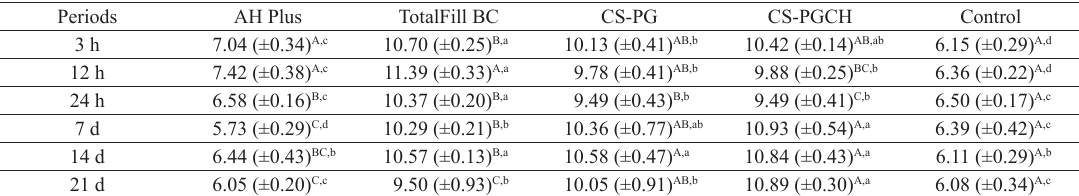
Table 3. pH values (mean and standard deviation) observed in the different experimental time intervals (3, 12 and 24 hours, 7, 14 and 21 days).